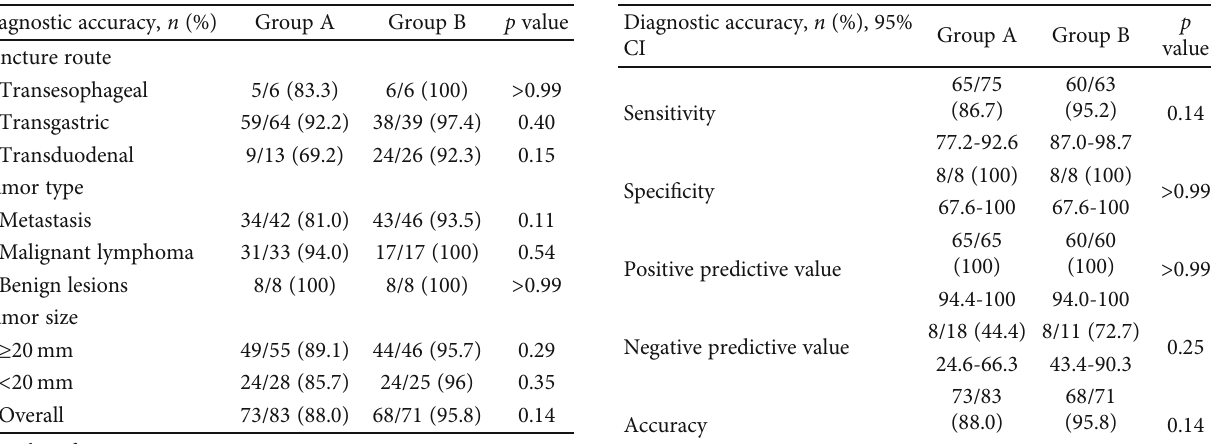
Table 7: Histological diagnostic performance comparisons for di ff erentiating between malignant and benign